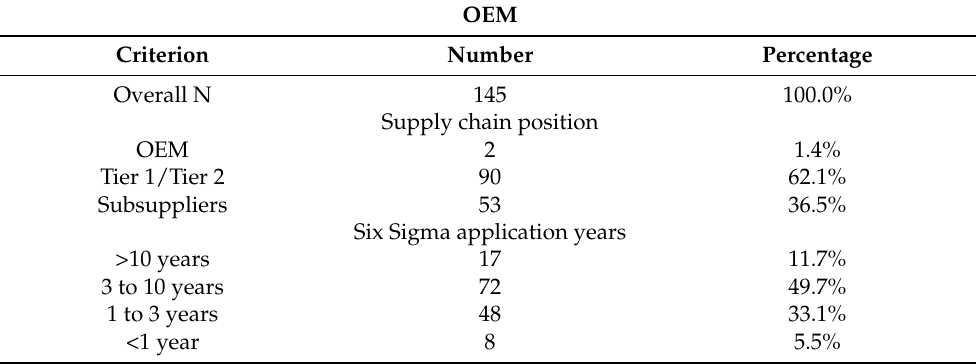
Table 1. Basic information on study